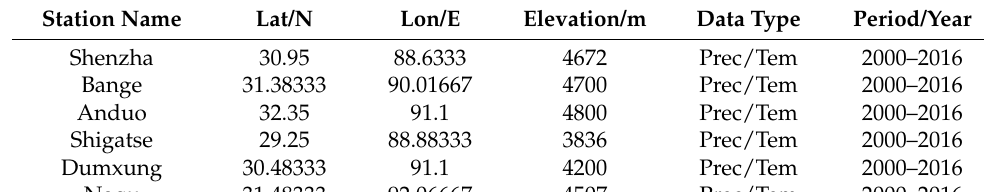
Table 1. Information on meteorological stations in the Siling Co basin.